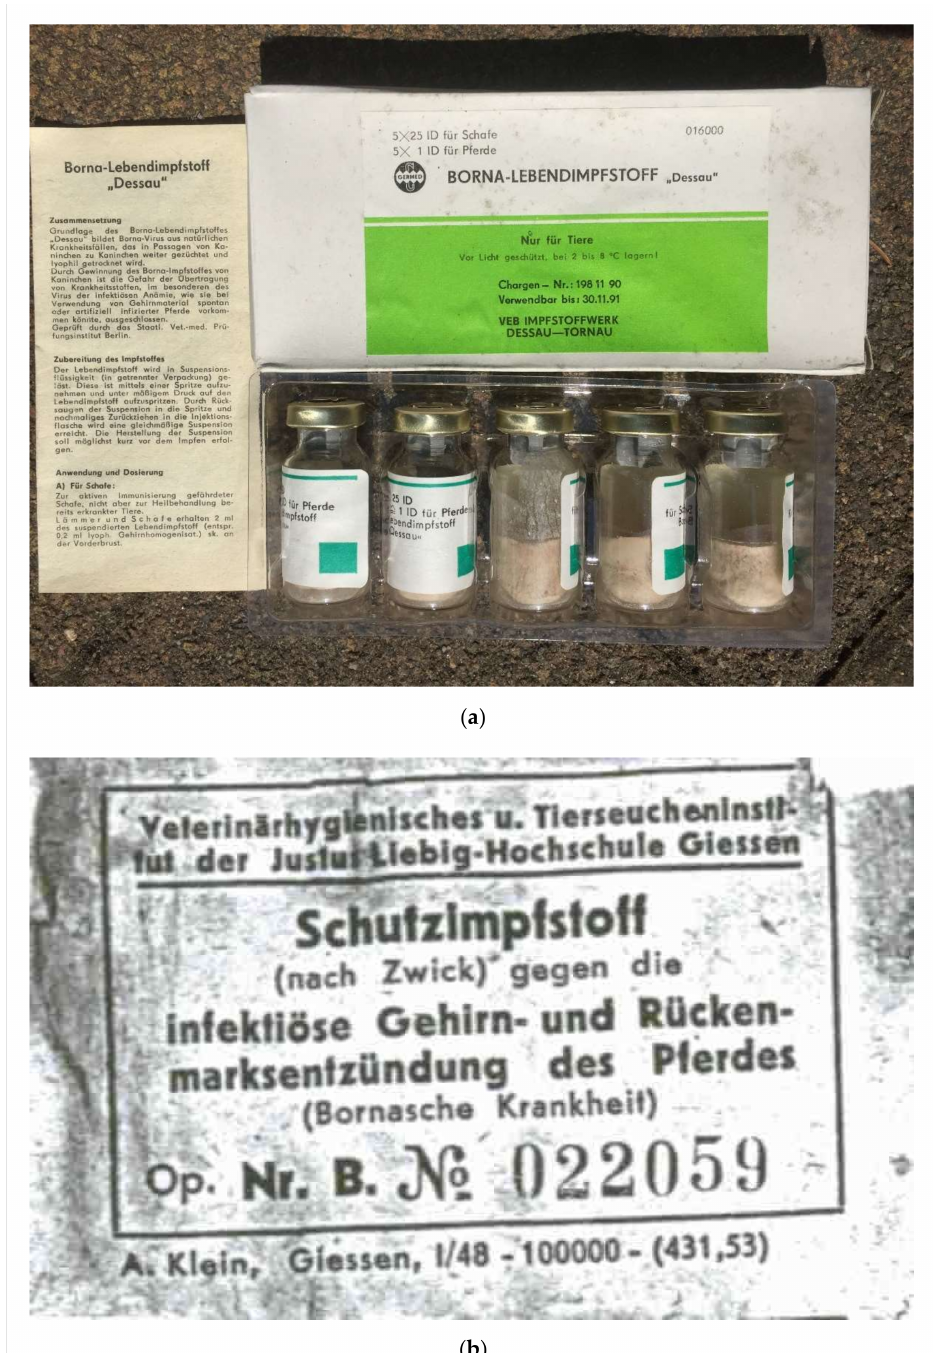
Figure 1. BoDV-1 vaccines used in Germany. ( a ) BD live virus vaccine “Dessau”, instructions for use (in German), package, and five vials containing lyophilized rabbit brain with BoDV-1 “Dessau” (cluster 3). Shown is the penultimate batch produced in November 1990, which was sequenced in this study ( b ) Label (in German) of the Zwick vaccine “Giessen” containing strain V from 1948, which was sequenced in this study (cluster